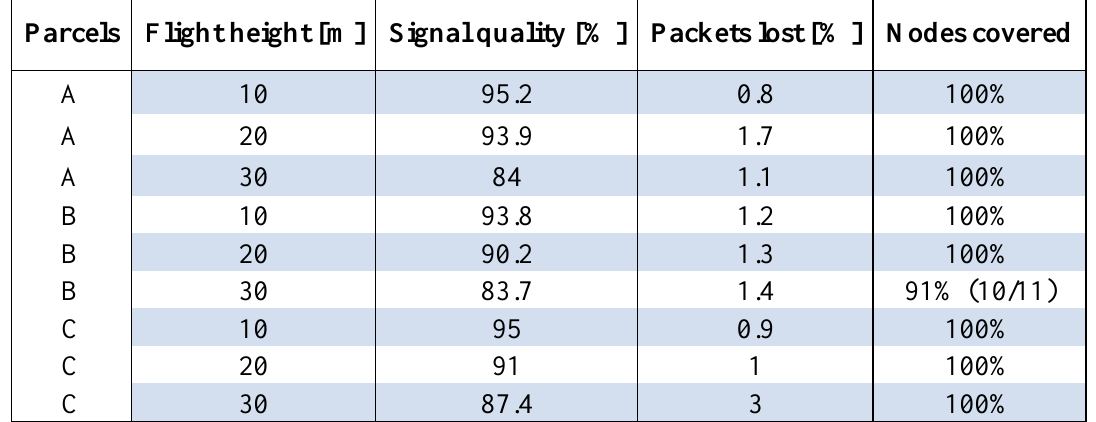
Table 2. Signal quality and packets lost during the remote sensing mission for each